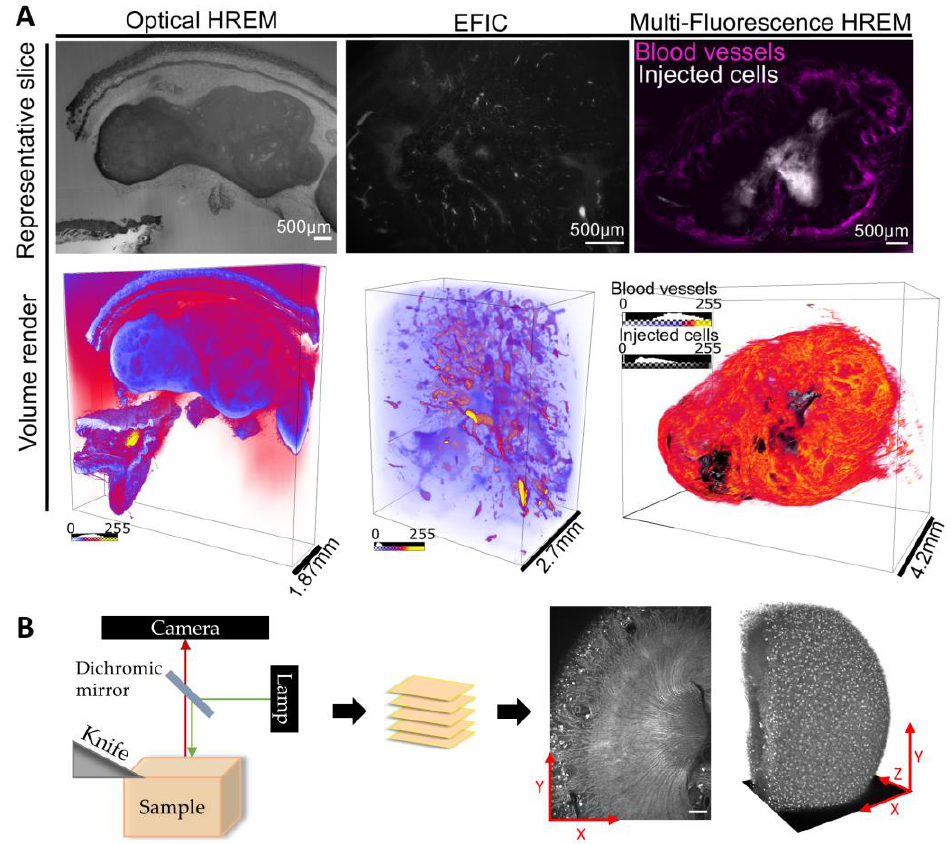
Figure 1. ( A ) Representative 2D slices are shown to illustrate a range of sources of contrast used in episcopic imaging: Optical HREM (eosin), EFIC (autofluorescence) and MR-HREM (targeted fluorescence labels). Reprinted with permission from Ref. [2]. All three panels show a subcutaneous murine tumor model. Different features are visible depending on the contrast source used. ( B ) A schematic illustration of an episcopic imaging system. A fluorescence microscope is positioned above a mechanized sample stage with inbuilt microtome blade. Sequential 2D images are captured of the block surface as the top layer of the sample is cut away the blade. The resultant stack of images is then reconstructed to create a 3D volume.